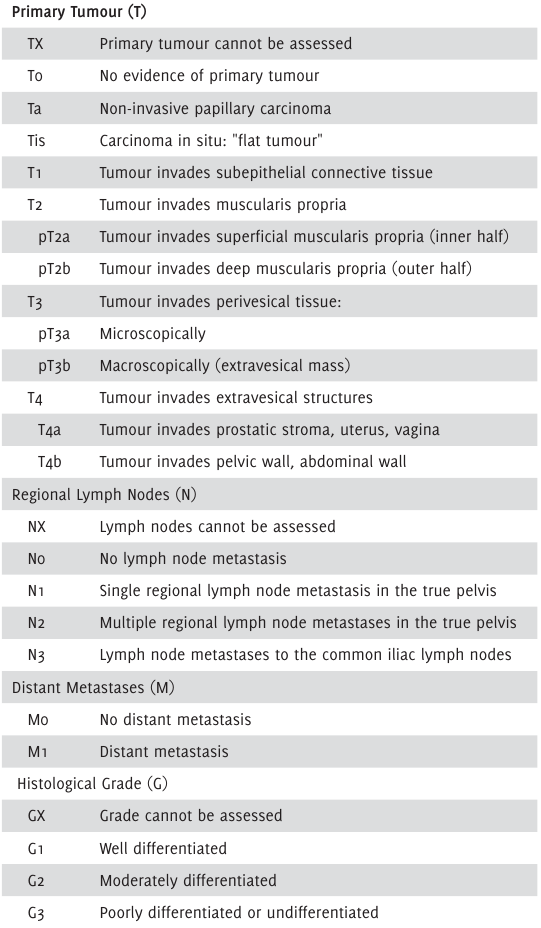
Source: Used with permission of the American Joint Committee on Cancer (AJCC), Chi- cago, Illinois. The original and primary source for this information is the AJCC Cancer Staging Manual, Seventh Edition (2010) published by Springer Science+Business Media.